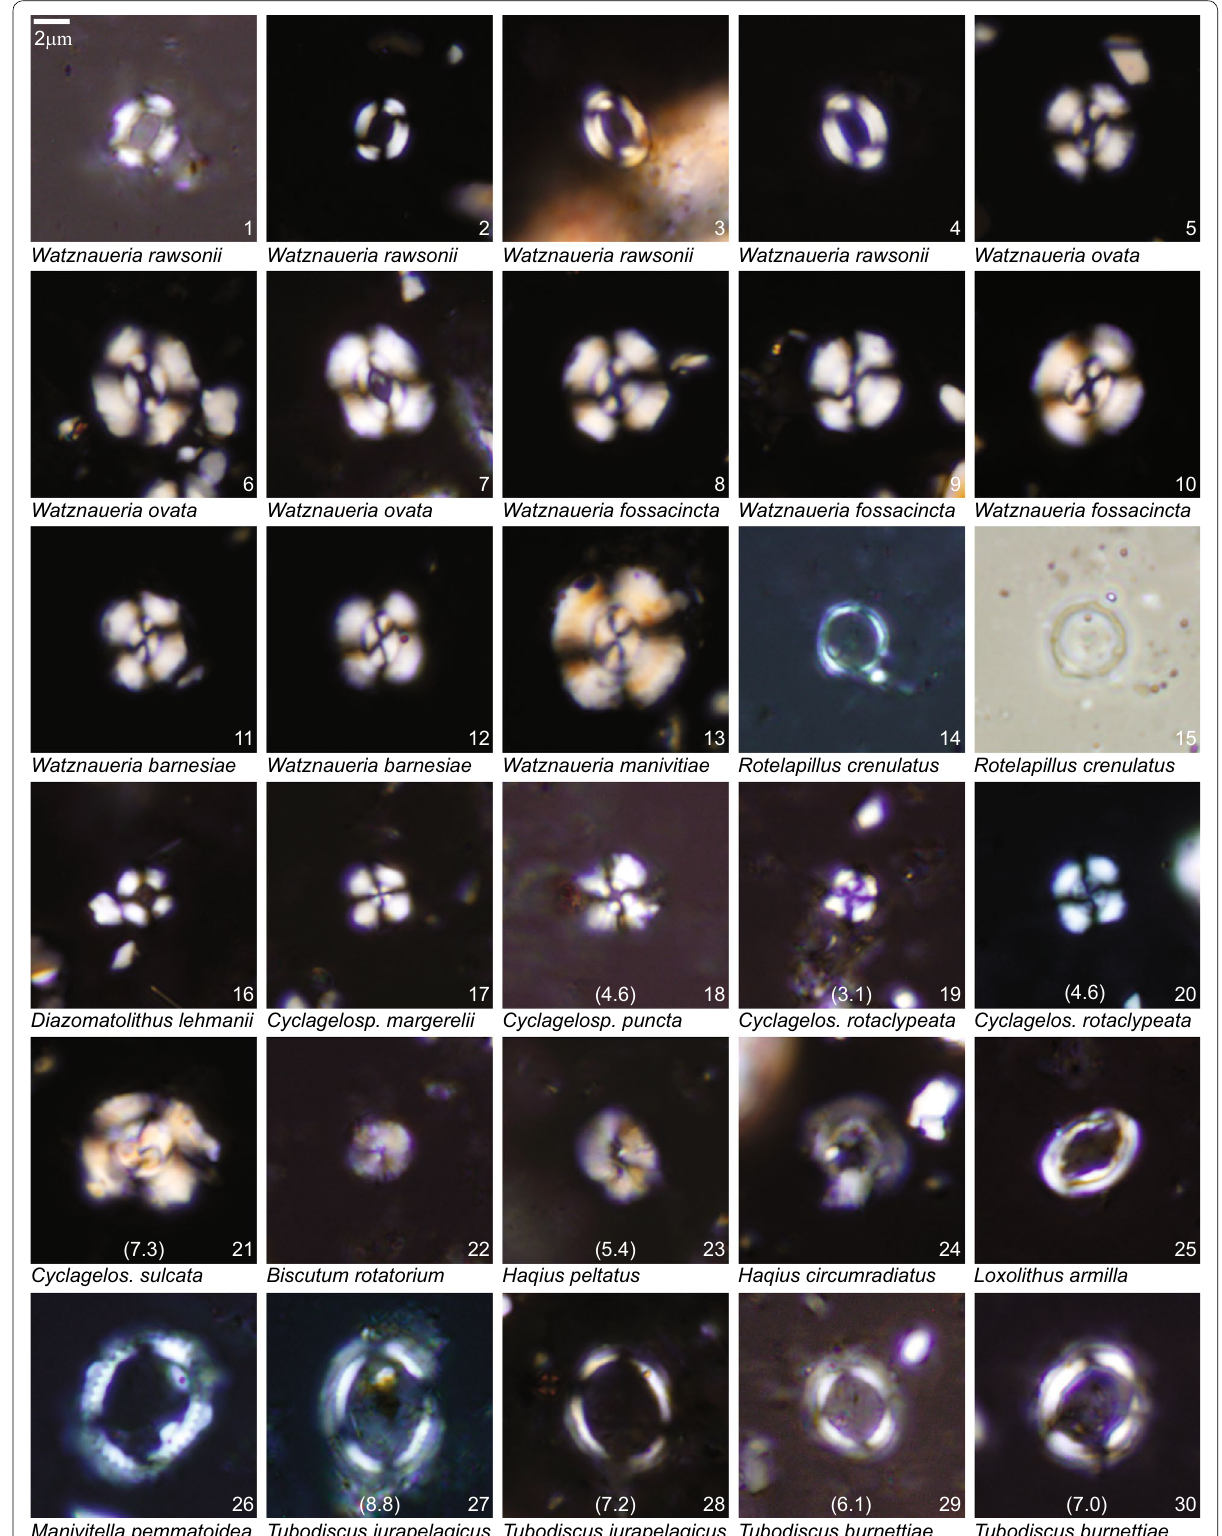
Fig. 11 Calcareous nannofossils from the Marnes de la Russille (Barremian) of the Swiss Jura Mountains. All LM pictures from La Sarraz–Les Buis quarry (without sample numbers: